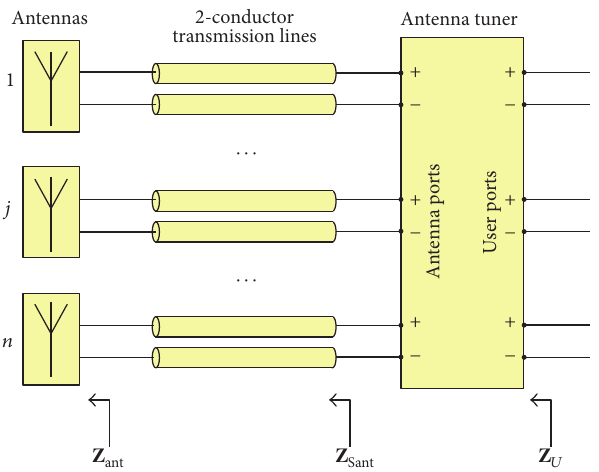
Figure 1: An array of 𝑛 antennas coupled to a MAPMUP antenna tuner through 𝑛 uncoupled 2-conductor transmission lines.